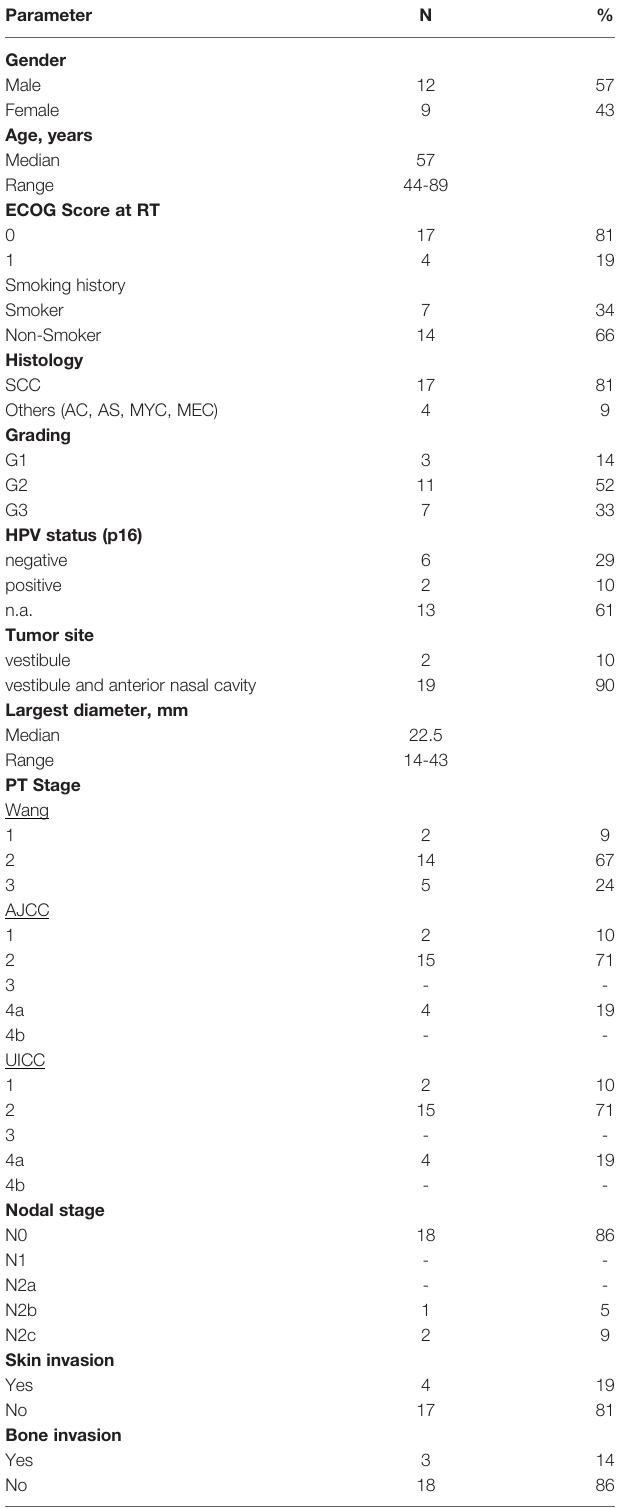
TABLE 2 | Patients ’